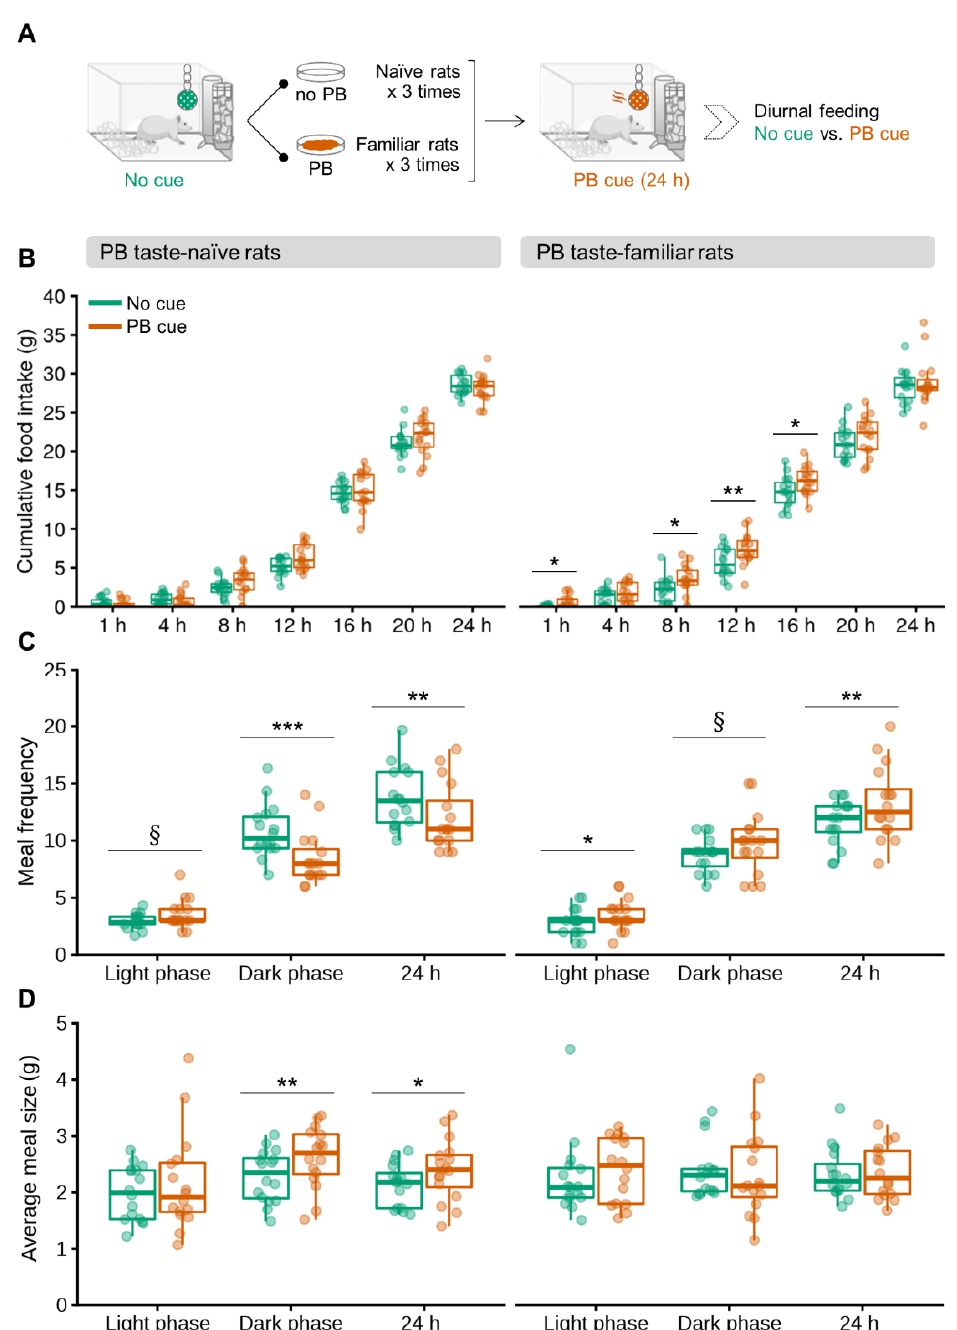
Figure 1. Olfactory detection of PB causes persistent overconsumption of regular chow due to an increase in meal frequency in non-food-deprived PB taste-familiar rats. ( A ) Schematic for the cross-over experimental design in the automated feeding monitoring cages; ( B ) cumulative food intake progression following introduction of the olfactory cue in the home-cage environment; ( C ) meal frequency and ( D ) average meal size (g) during the light phase, dark phase and total day (24 h) in PB taste-naïve rats (left, n = 16) and PB taste-familiar rats (right, n = 16). For illustration, the thick line always corresponds to the median, boxes show first and third quartiles and whiskers represent minimum and maximum values. Symbols indicate differences between the control and the PB cue conditions at (*) p < 0.05, (**) p < 0.01, (***) p < 0.001 or (§) 0.05 ≤ p < 0.1 by one-way repeated measures ANOVA followed by paired samples t -tests upon data split according to Conditioning (naïve, familiar). PB; peanut butter.